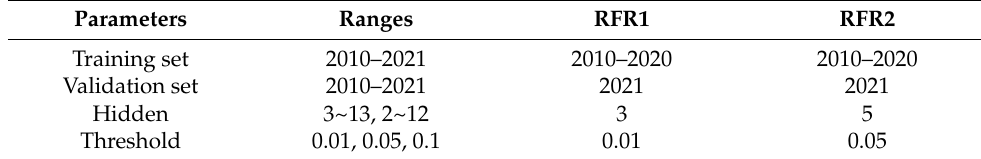
Table 6. Back Propagation Neural Network parameter selection.